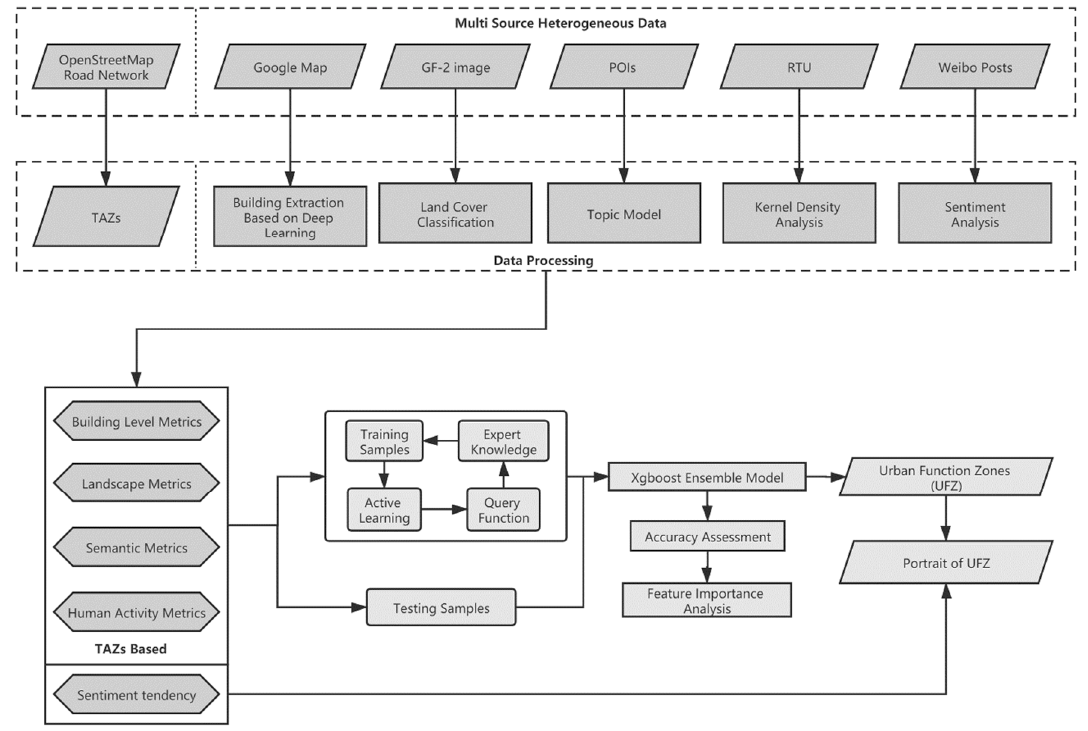
Figure 2. Diagram of the methodological framework of urban functional zone identification. Traffic analysis zones (TAZs) are taken as the basic functional units in this study.